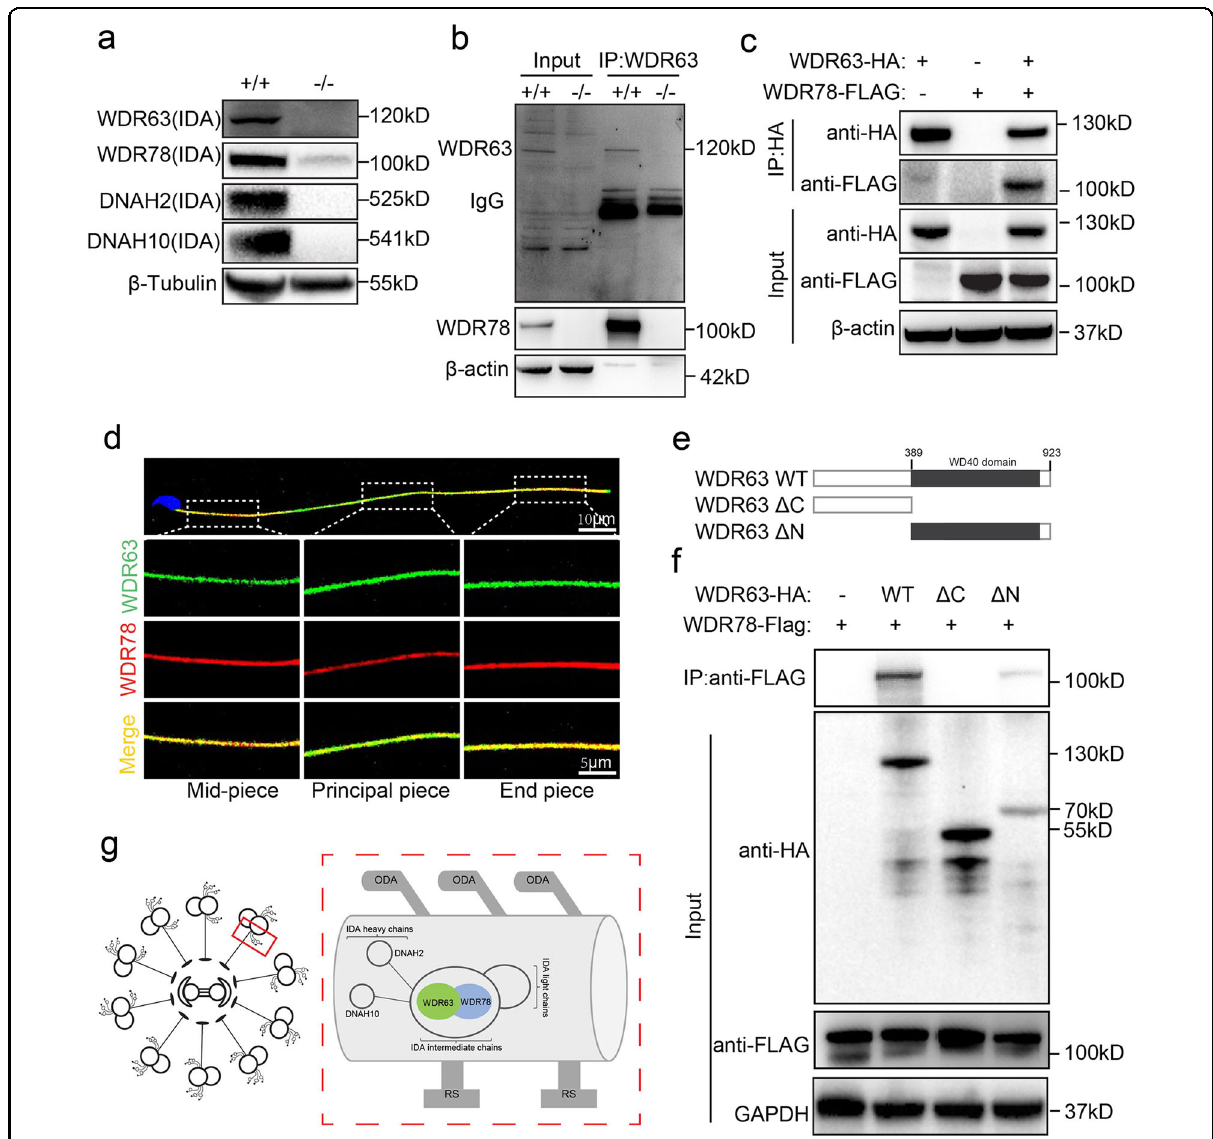
Fig. 5 WDR63 associates with WDR78 and their interaction is necessary for IDA assembly. a Western blot analysis of WDR63, WDR78, DNAH2 and DNAH10 in testes of Wdr63 + / + and Wdr63 − / − male mice. b Immunoprecipitation with testicular extracts using anti-WDR63 antibodies, Mass spectrometric analysis identi fi ed WDR78 is the potential associated proteins. Western blot analysis and con fi rmed that WDR63 interacts with WDR78. c HA-WDR63 and/or FLAG-WDR78 expression constructs were transfected into HEK293T cells. After 48 h, the cells were collected for immunoprecipitation analysis with indicated anti-HA and anti-FLAG antibodies. d Immuno fl uorescence analysis indicated that WDR63 co-localized with WDR78 in normal spermatozoon. e Schematic diagram of mouse wild type WDR63 (NP_766452.2) and truncated constructs. WD40 repeats domains are marked in a gray box (398 – 785 aa, UniProt ID: B2RY71). WDR63 Δ C, deletion of the C terminal domain of WDR63 (398 – 923 aa); WDR63 Δ N, deletion of the N terminal domain of WDR63 (1 – 397 aa). f HA-WDR63 WT, HA-WDR63 Δ C and HA-WDR63 Δ N were co-transfected with FLAG-WDR78 into HEK293T cells, respectively. After 48 h, the cells were collected for immunoprecipitation analysis with the indicated antibodies. g Schematic of the role of WDR63 interacts with WDR78 in IDAs